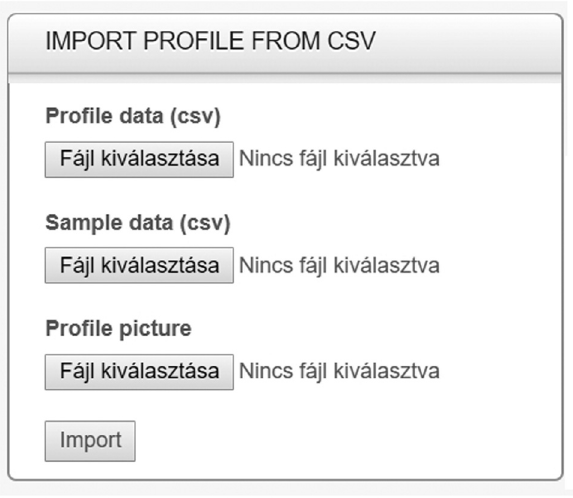
Figure 17: Interface of import menu.